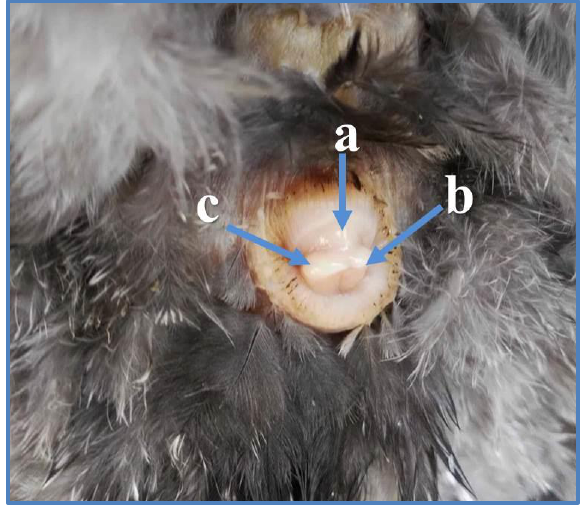
Figure,7: Gross appearance of copulatory organ of guinea fowl showing: dorsal lip of wall (a)right lateral body (b), left lateral body (c)